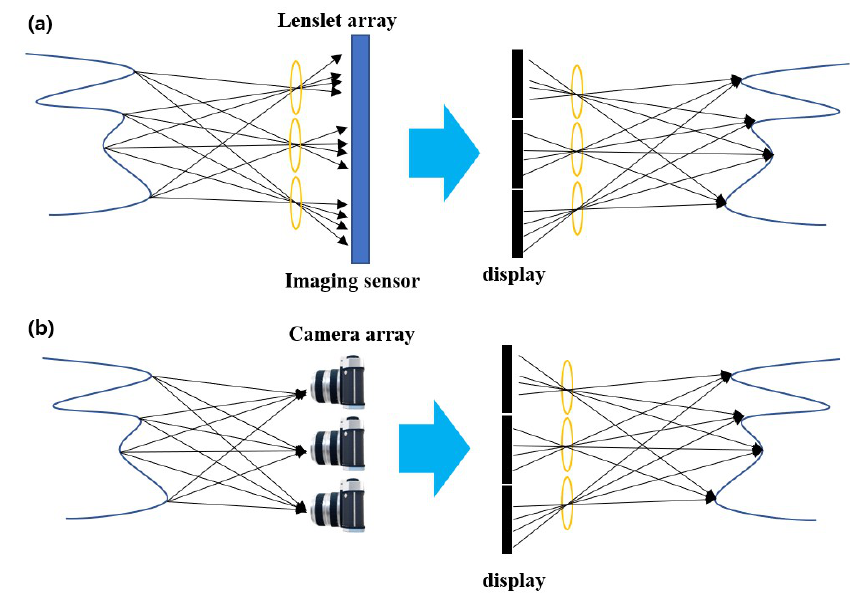
Figure 1. Basic concept of integral imaging by using ( a ) lenslet array and ( b ) camera